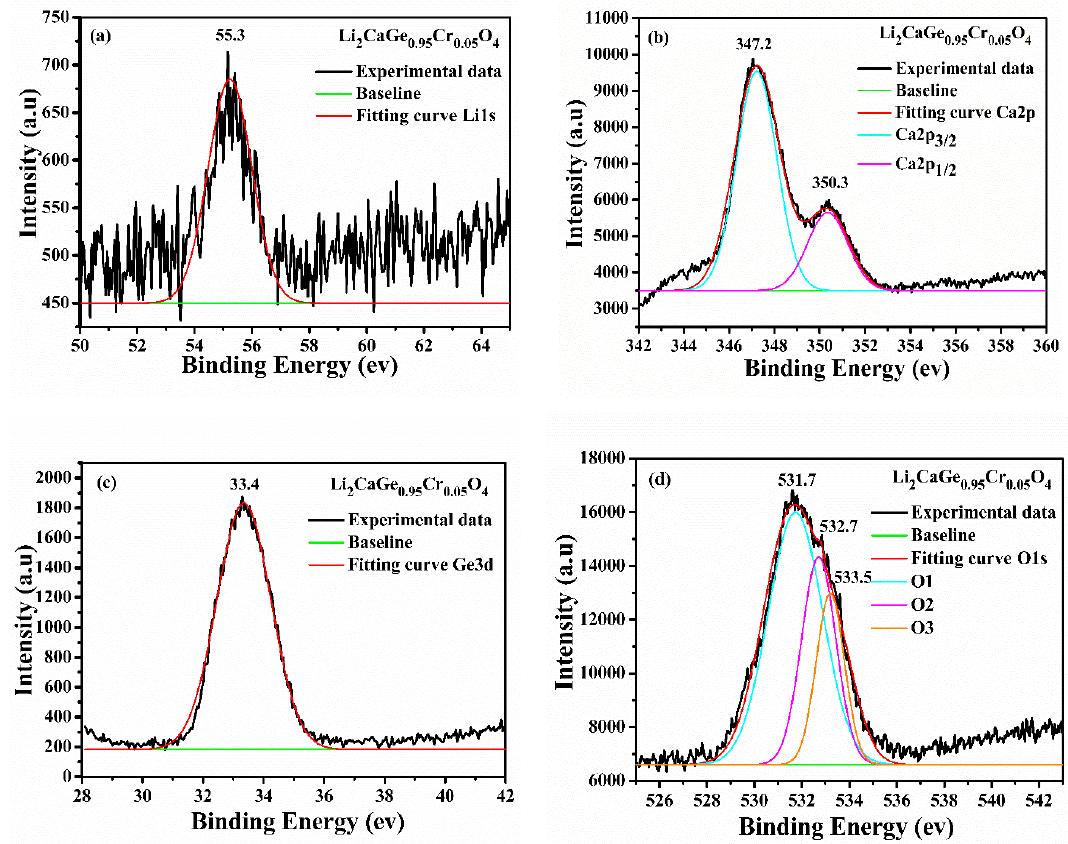
Figure 14. Narrow scanning spectra of XPS for the other elements: ( a ) Li1s, ( b ) Ca2p, ( c ) Ge3d, and ( d ) O1s.